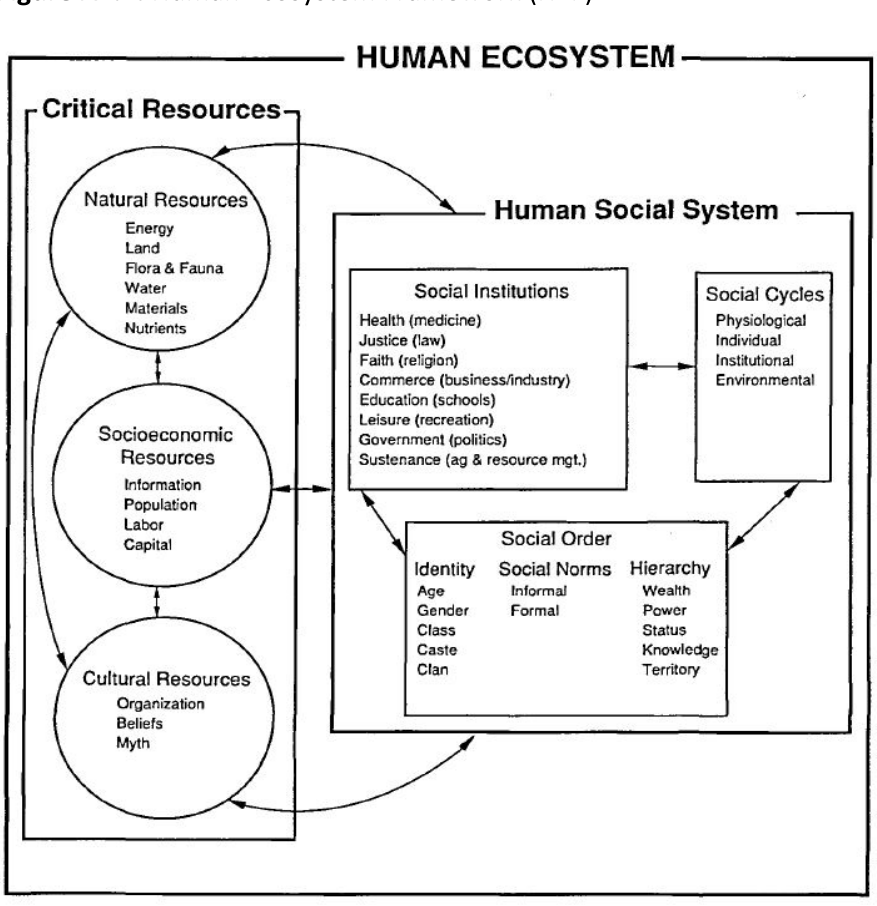
Figure A2.1. Human Ecosystem Framework